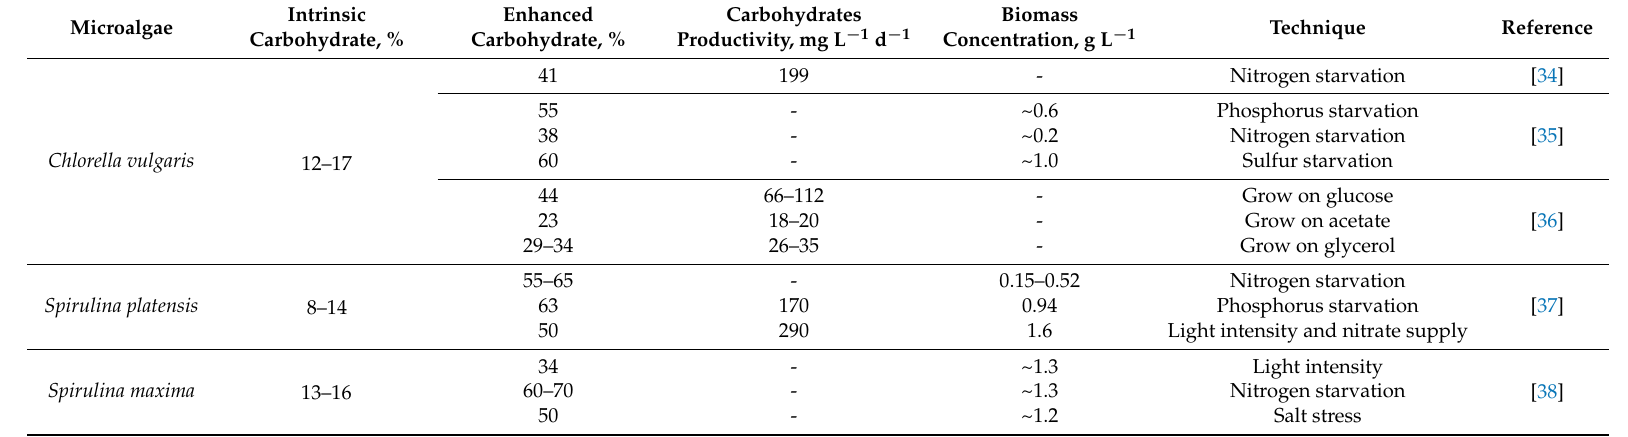
Table 2. Intrinsic and enhanced carbohydrates biomass content after use of a cultivation